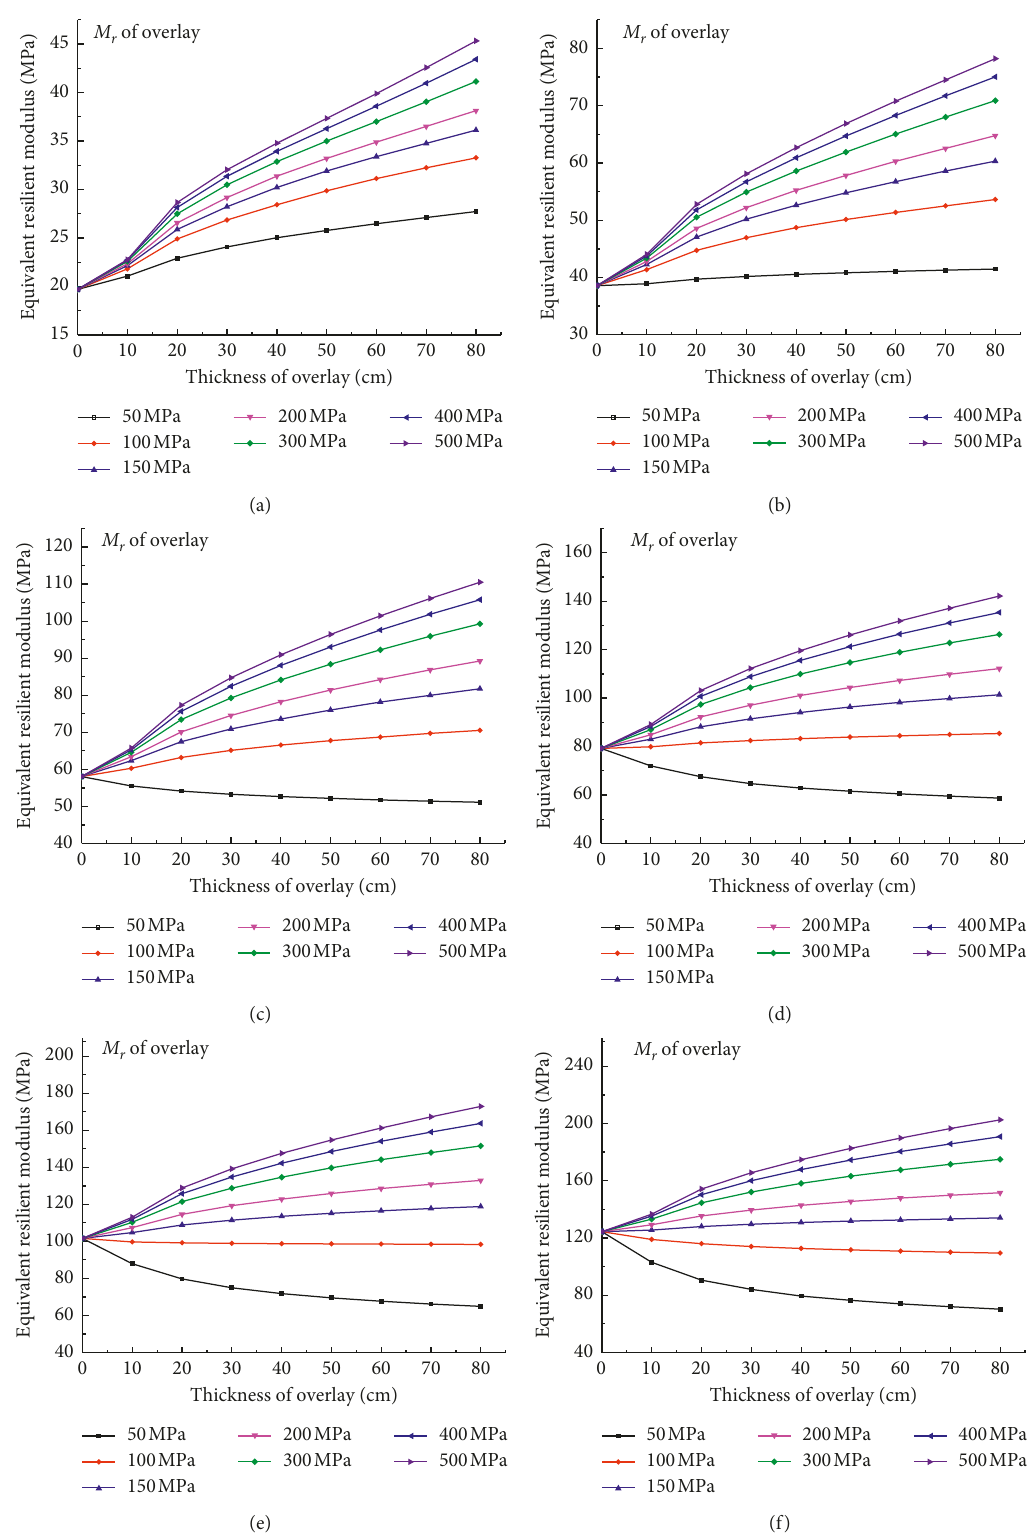
Figure 3: Equivalent resilient modulus with different M r of subgrade soil and thicknesses of the overlay. The M r of subgrade soil is (a) 20 MPa, (b) 40MPa, (c) 60MPa, (d) 80MPa, (e) 100MPa, and (f)